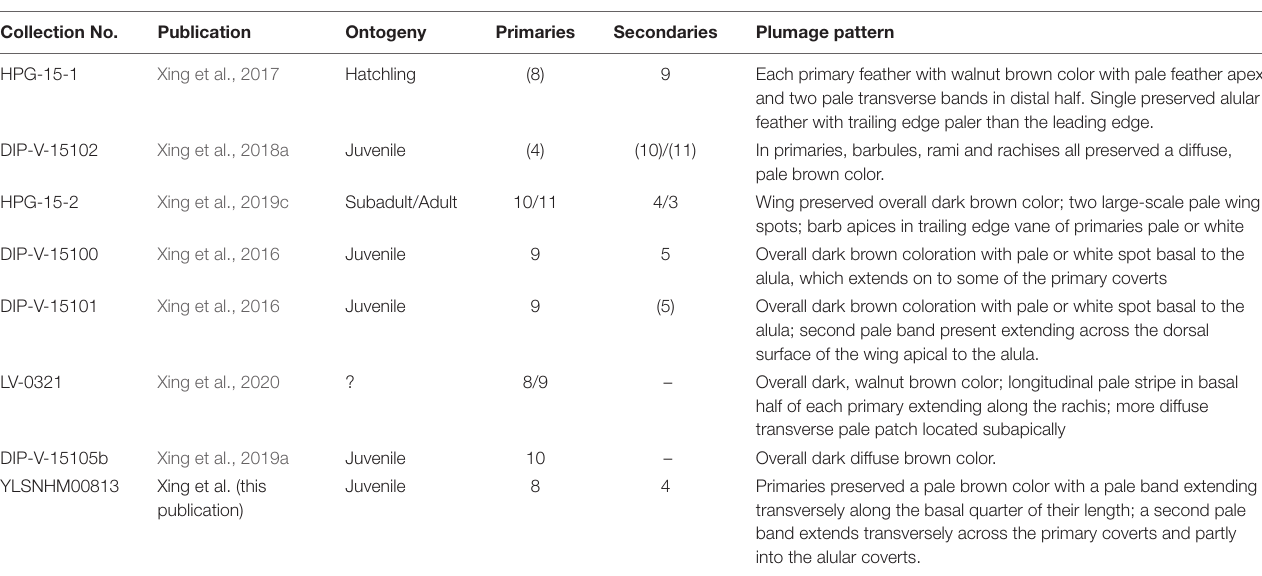
TABLE 2 | Wing plumage characteristics in Hukwang enantiornithines. Collection No.